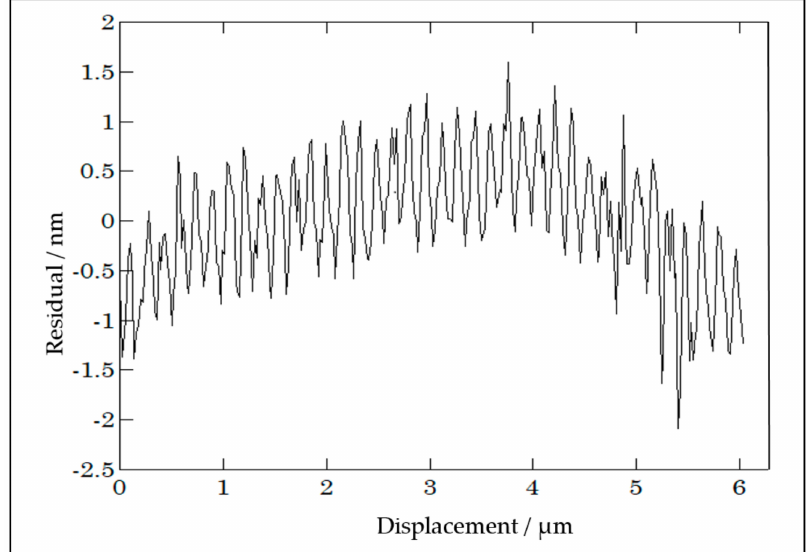
Figure 5. Calibration result of an inductive probe (Mahr Millitron), using the calibration set-up